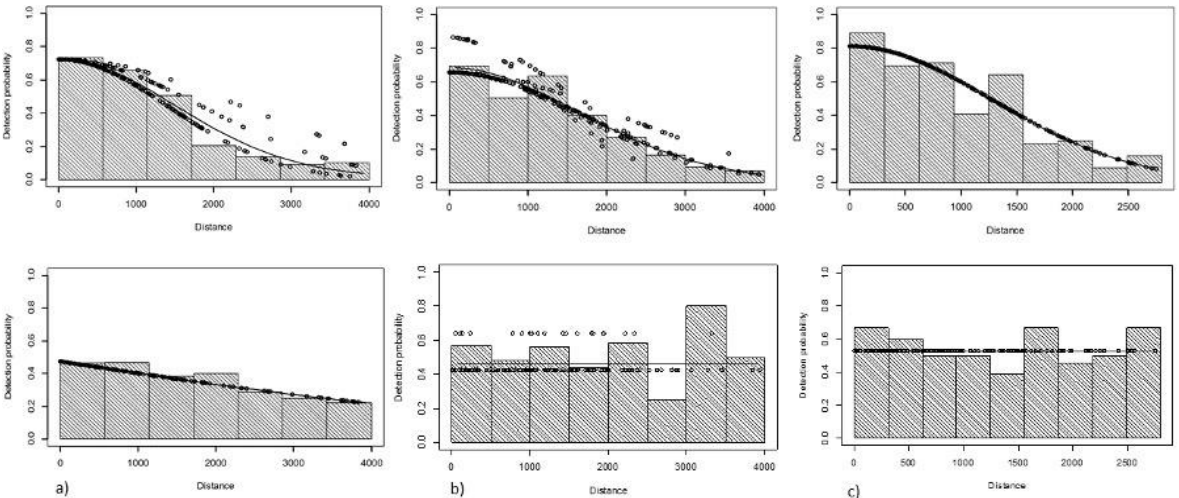
Figure 4. 2002 – 2007 survey detection function curves for pooled detections (top) and the conditional detection probabilities of platform 1 (bottom) for (a) fin whales, (b) humpback whales, and (c) sperm whales.